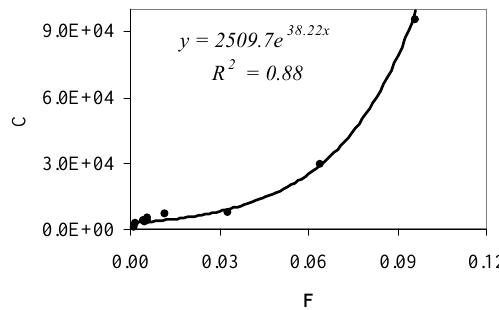
Fig. 7. Inter-plot statistical relations between parameters C – F Fig. 7 . Inter-plot statistical relations between parameters C- F .